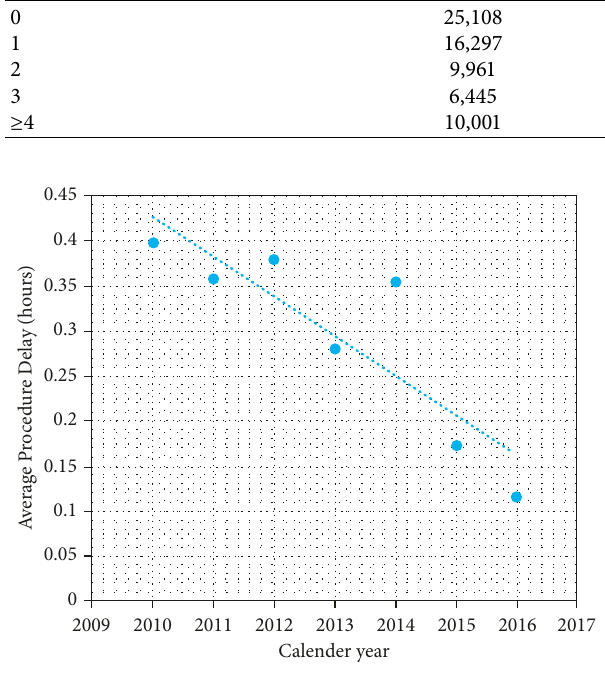
Figure 2: Linear trend ( R � 0.87) observed in average procedure delay across calendar years 2010 through